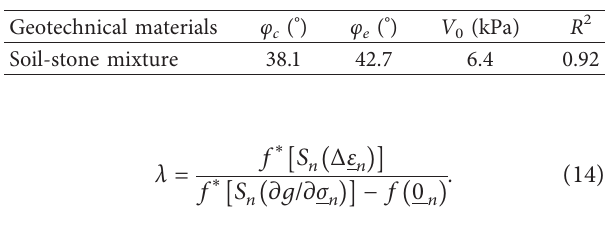
Figure 4: Comparison of PMC strength curve and test data in p - q plane of soil and stone mixture. Table 1: PMC material parameters of soil-stone